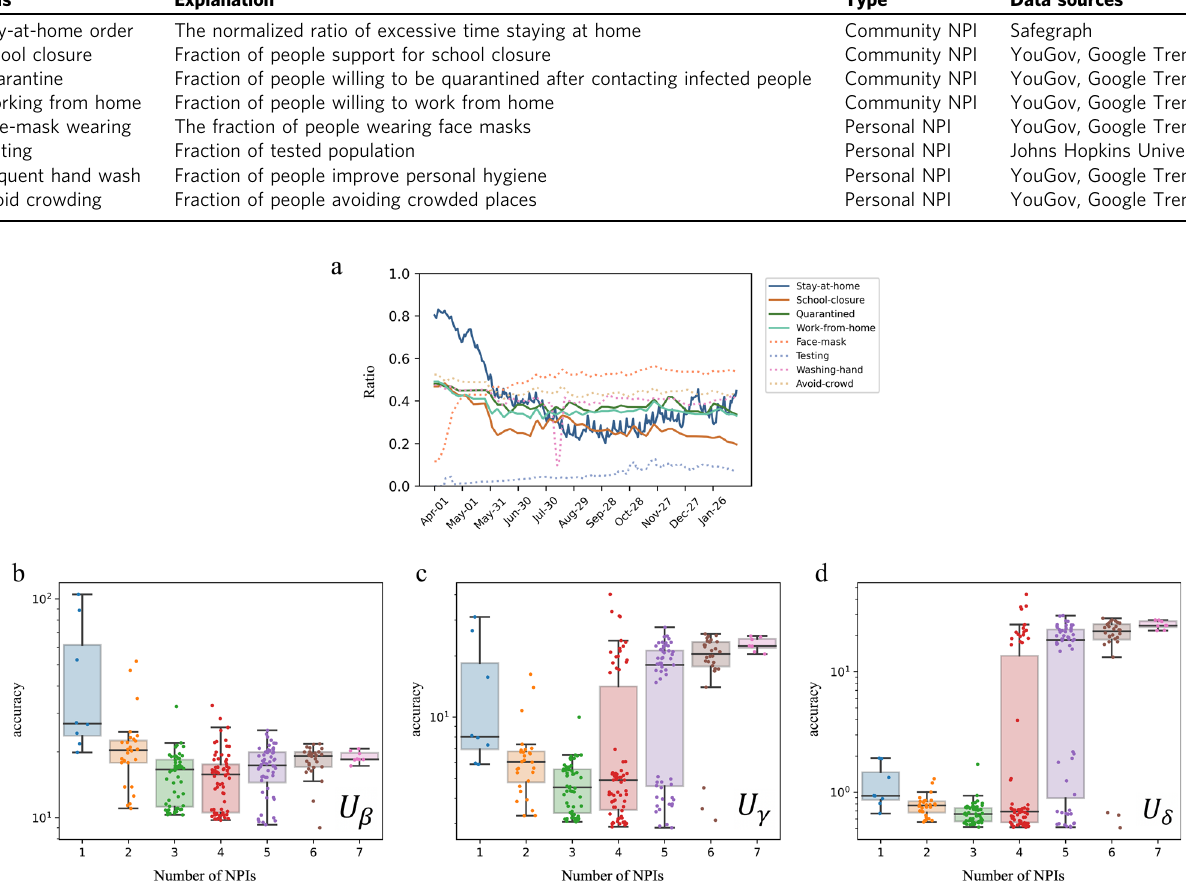
Fig. 3 NPIs selection for predicting the designed controllers U Θ . Given eight NPIs ( a ), i.e., stay-at-home order, school closure, quarantine, working from home, face-mask wearing, testing, frequent hand wash, and avoid crowding, we test the accuracy of the predictive model with different combinations of NPIs for U β ( b ), U γ ( c ), and U δ ( d ). The model achieves high parsimony (with fewer NPIs) and a high level of goodness of fi t (with the lowest mean absolute error) using three NPIs, which are stay-at-home order, face-mask wearing, and